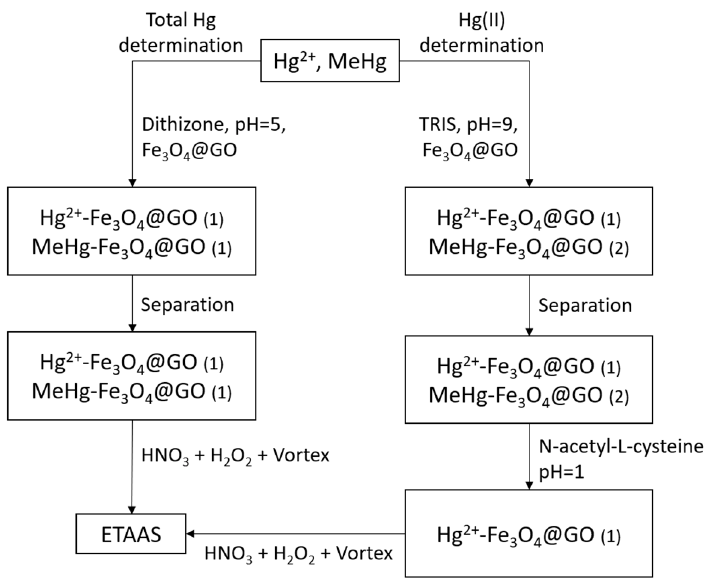
Figure 4. Scheme of the process from extraction to analysis. Complete and incomplete retentions of the analytes are represented by (1) and (2), respectively.